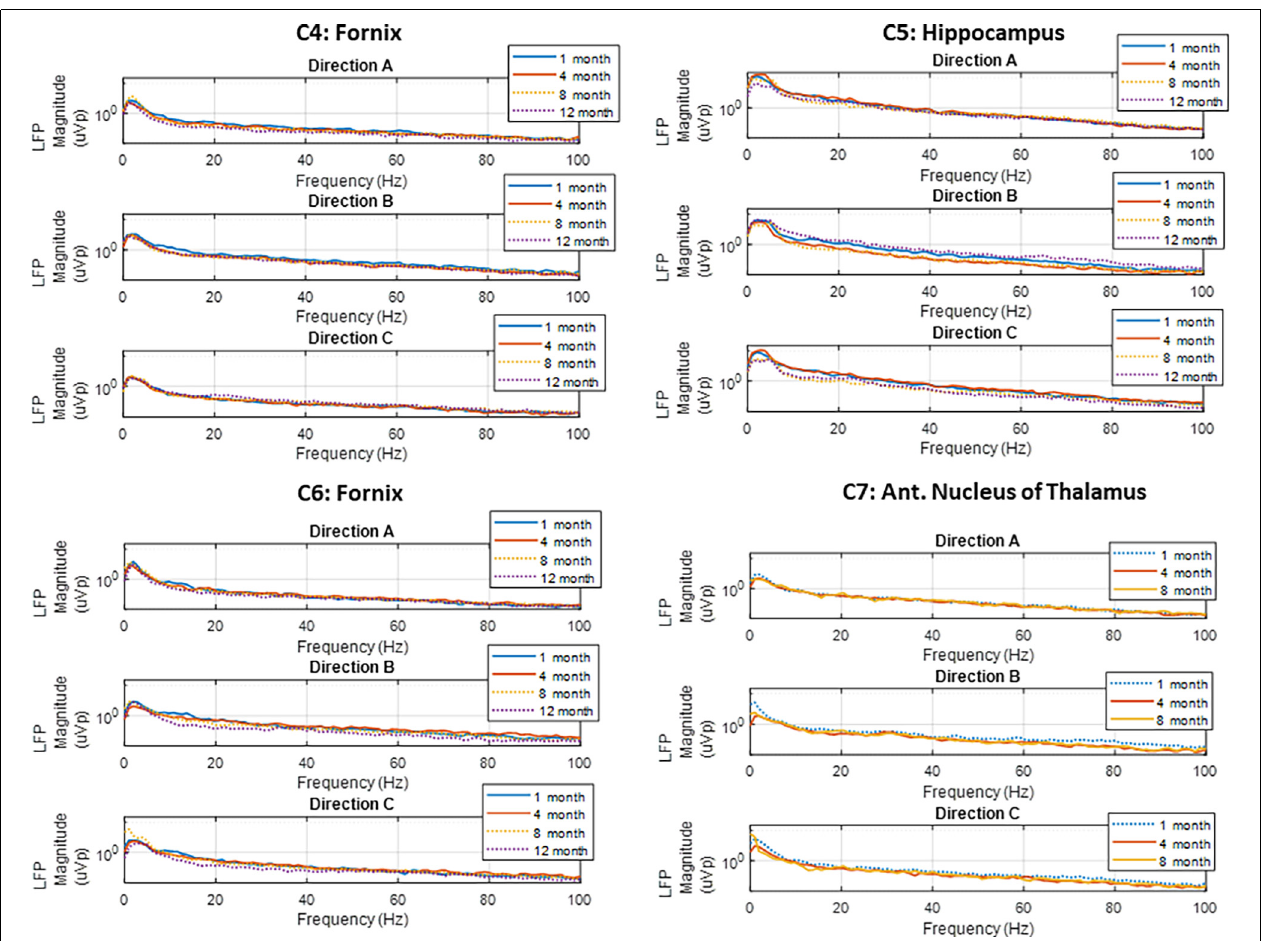
FIGURE 5 | Local field potentials. Representative examples of LFP power spectra from directional pairs (E1a-E2a, E1b-E2b, E1c-E2c) recorded over the study period for the four subjects implanted with directional leads. Recordings showed predominant theta activity in all nodes monitored. The dotted line denotes the free-roaming condition, and the solid line denotes the sling condition. Each line represents one 30 s sense recording for the representative study